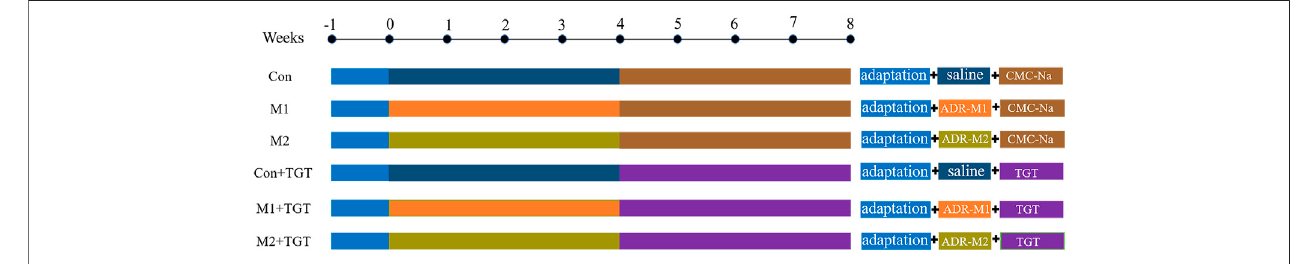
FIGURE 2 | The experimental scheme for evaluating the ef fi cacy and hepatotoxicity of TGT in adriamycin-induced-NS rats.